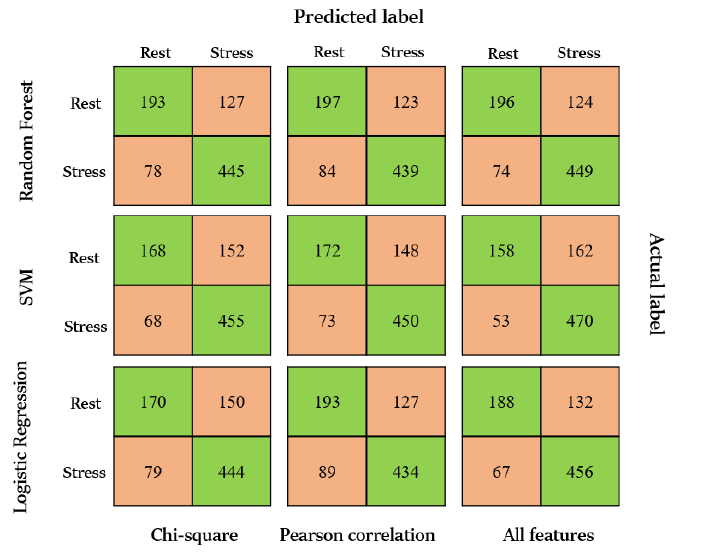
Figure 4. Ranks listed in order of importance for each feature extracted: ( A ) Chi-test method. ( B ) Pearson’s correlation coefficient.